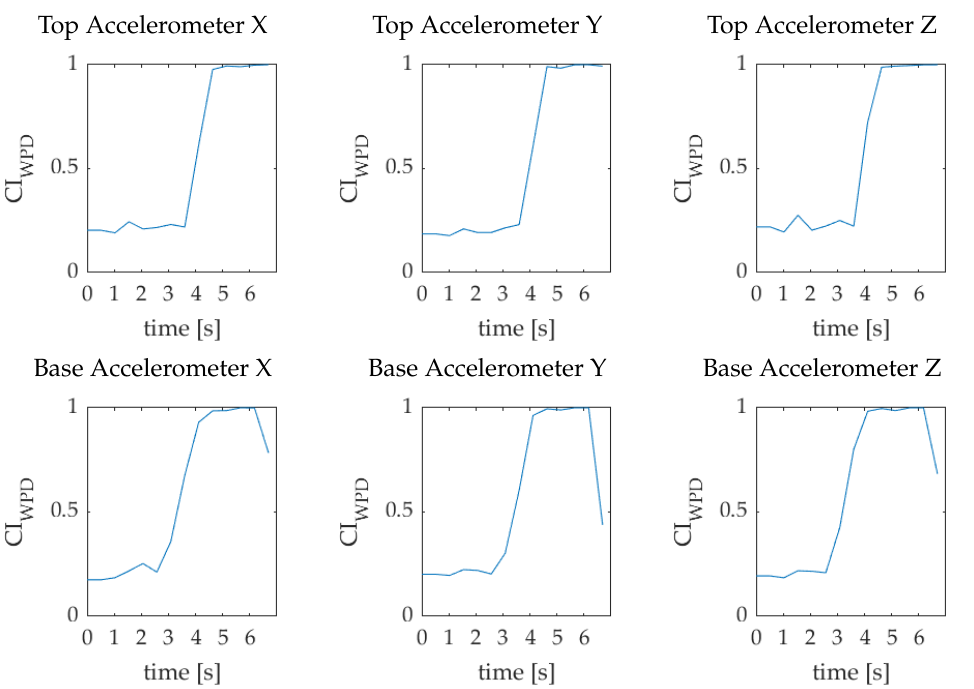
Figure 16. Wavelet chatter indices for Experiment